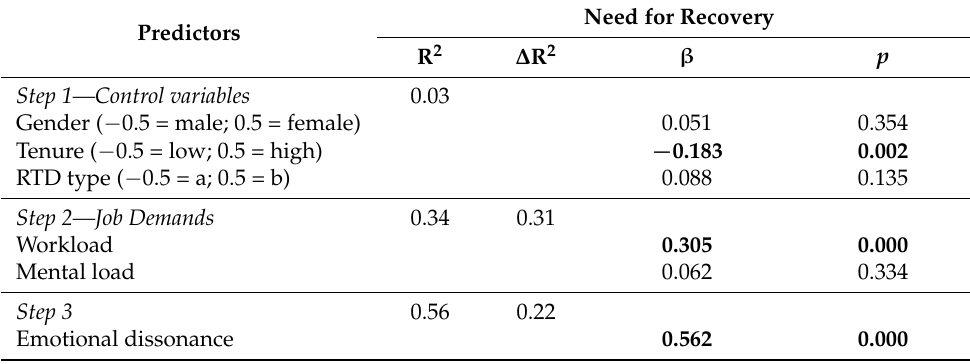
Table 2. Coefficients table of hierarchical regression analysis with Need for Recovery as outcome ( n =